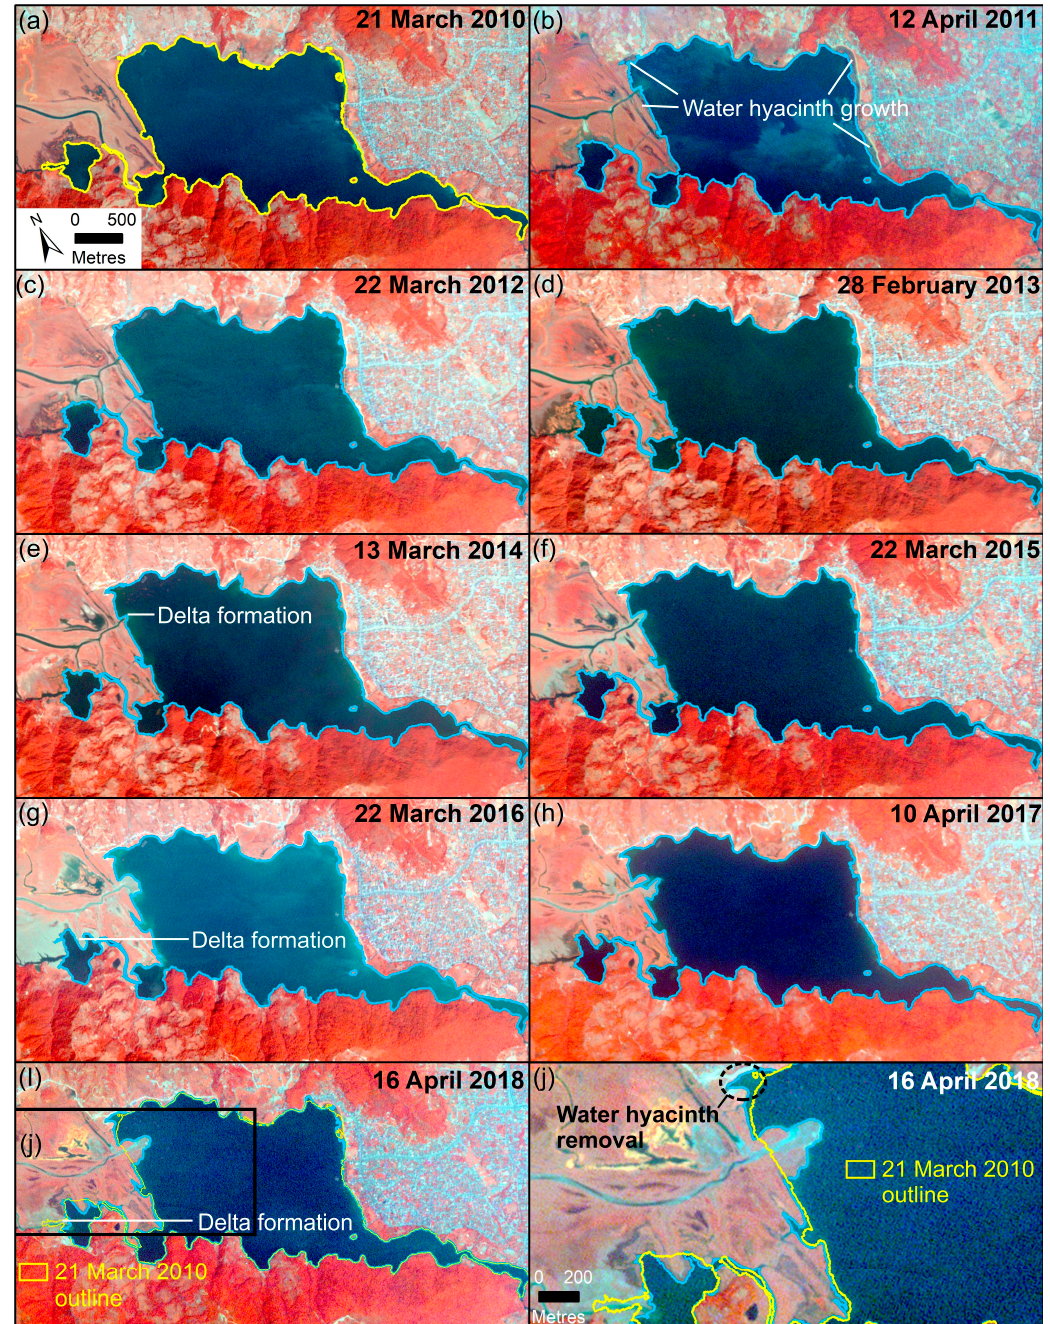
Figure 8. Changes in lake area from 2010–2018 and the locations of sediment influx. Backgrounds are RapidEye false colour composites (bands: near-infrared, red, and blue). The corresponding classified lake outlines are shown as blue outlines (yellow outline for March 2010).